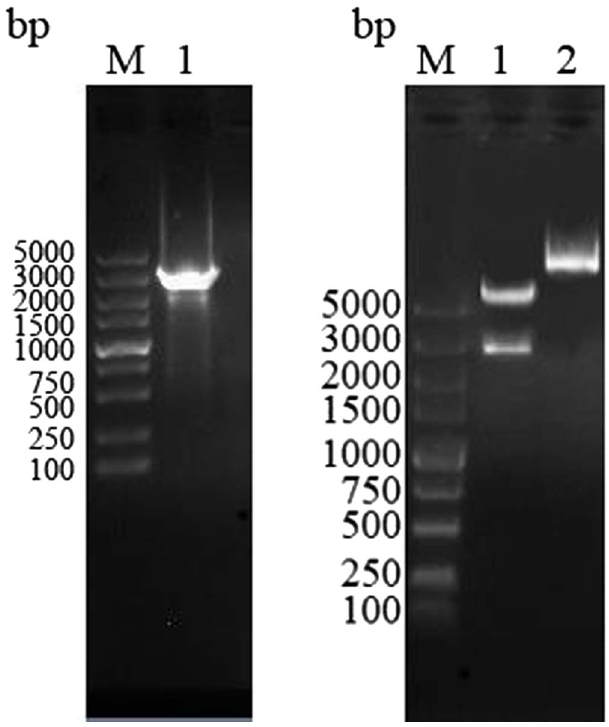
Figure 1. Construction and restriction endonuclease analysis